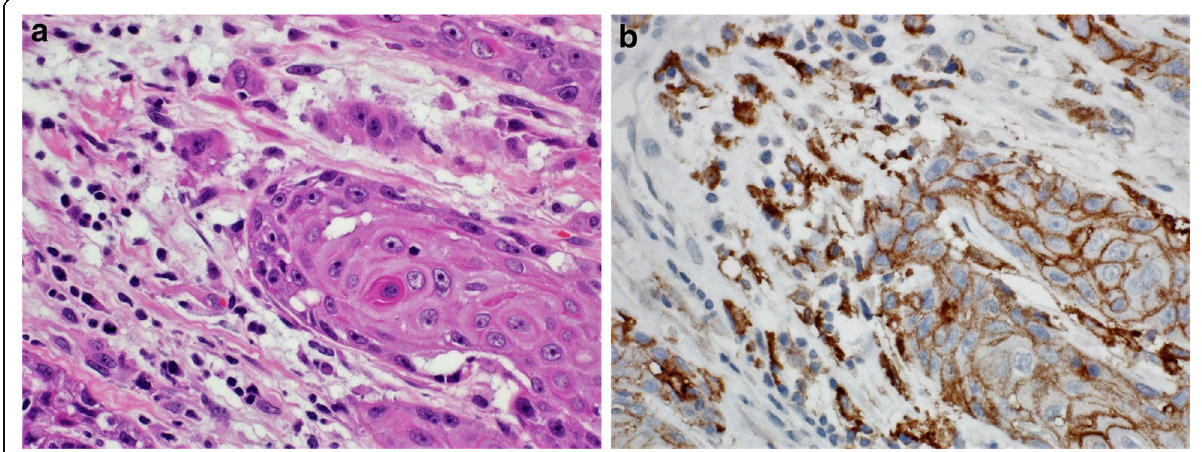
Fig. 12 A Case of buccal mucosa squamous cell carcinoma. B Immunohistochemical staining for PD-L1 revealing staining of tumor cells (right side of the figure) and tumor immune cells (left side of the figure). CPS: 90 (DAKO 22C3